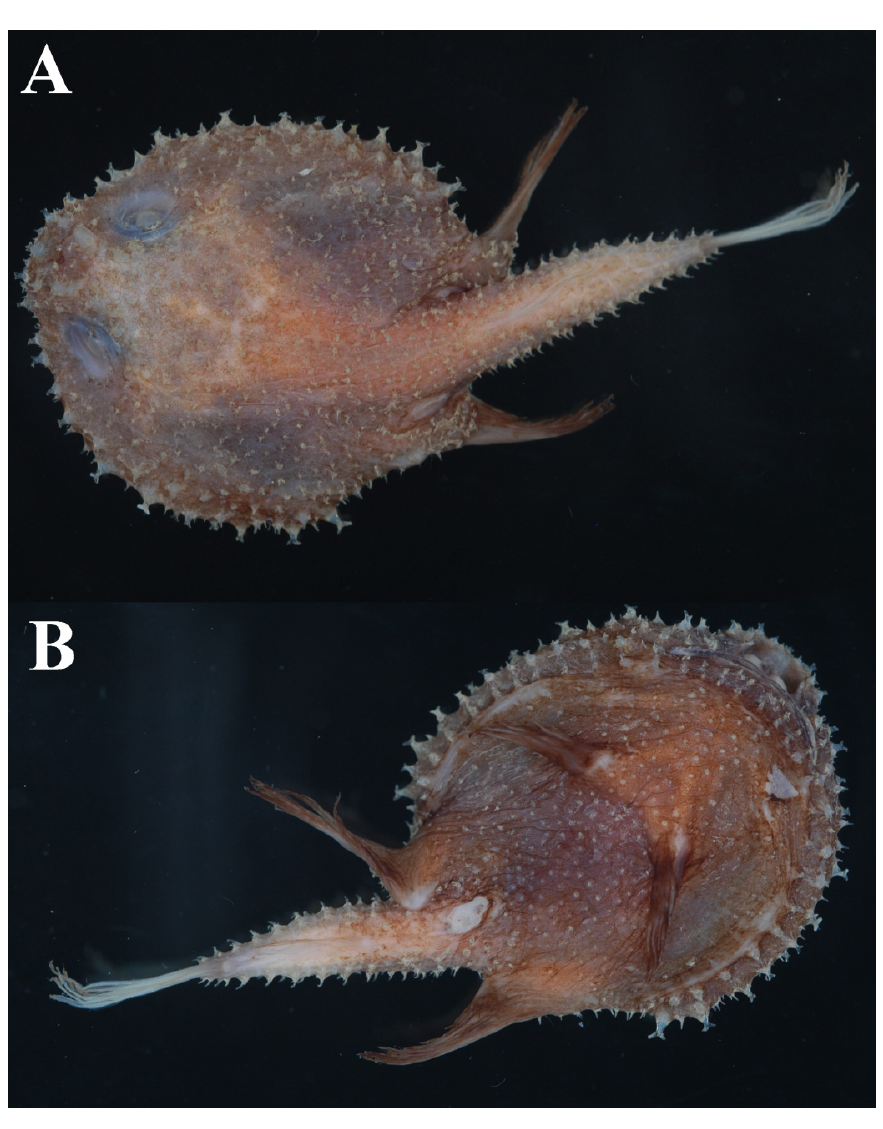
Figure 26. Halieutopsis oblonga (Smith and Radcliffe, 1912), nontype, FRIP 0516, 58.0 mm SL, southwestern Taiwan. ( A ). Dorsal view. ( B ). Ventral view.